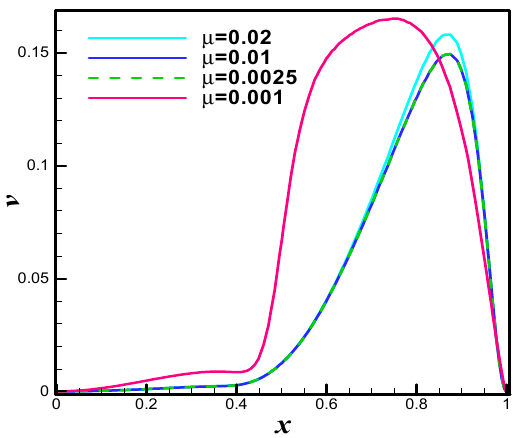
Figure 19. The u - velocity profile for case-I.